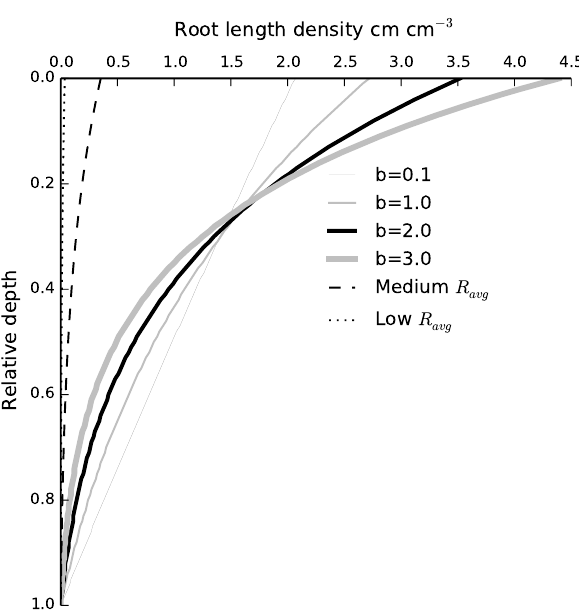
Figure 3. Root length density distribution over depth calculated by Eq. (30) for several values of b and R avg = 1.0cmcm − 3 and for low and medium R avg with b =